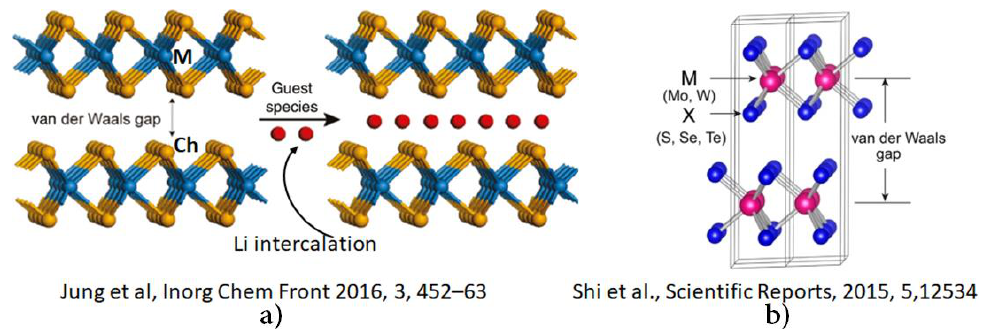
Figure 6. Examples showing the van der Waals gap in 2H-MCh 2 layered crystals, as reported in two different studies. The figure on ( a ) is reproduced from [49], with permission from the Royal Society of Chemistry, which shows a van der Waals gap and Li intercalation between the two chalcogenide monolayers of 2H-MCh 2 . The figure on ( b ) illustrates the same van der Waals gap reported by Shi et al ( Sci. Rep. 2015 , 5, 12534), yet persisting between the two metal layers of MCh 2 , in which, the sole importance of the two chalcogenide layers responsible for the so-called van der Waals gap shown